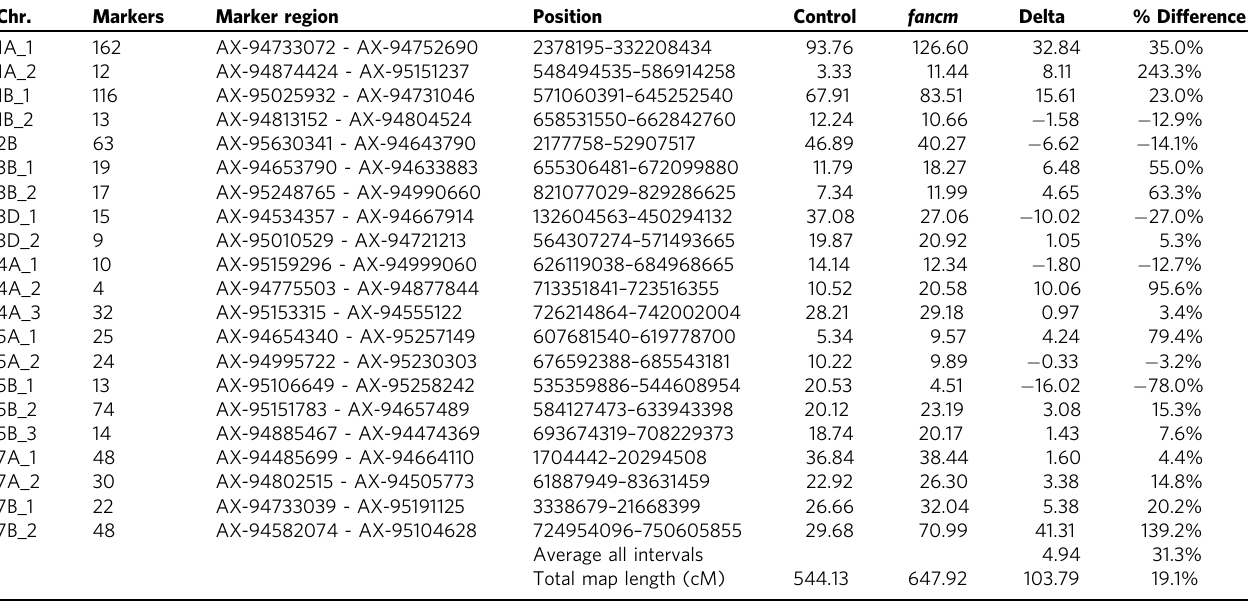
Table 1 Recombination analysis in the hexaploid Avalon x Cadenza F 3 fancm mutant mapping population. Chr. Markers